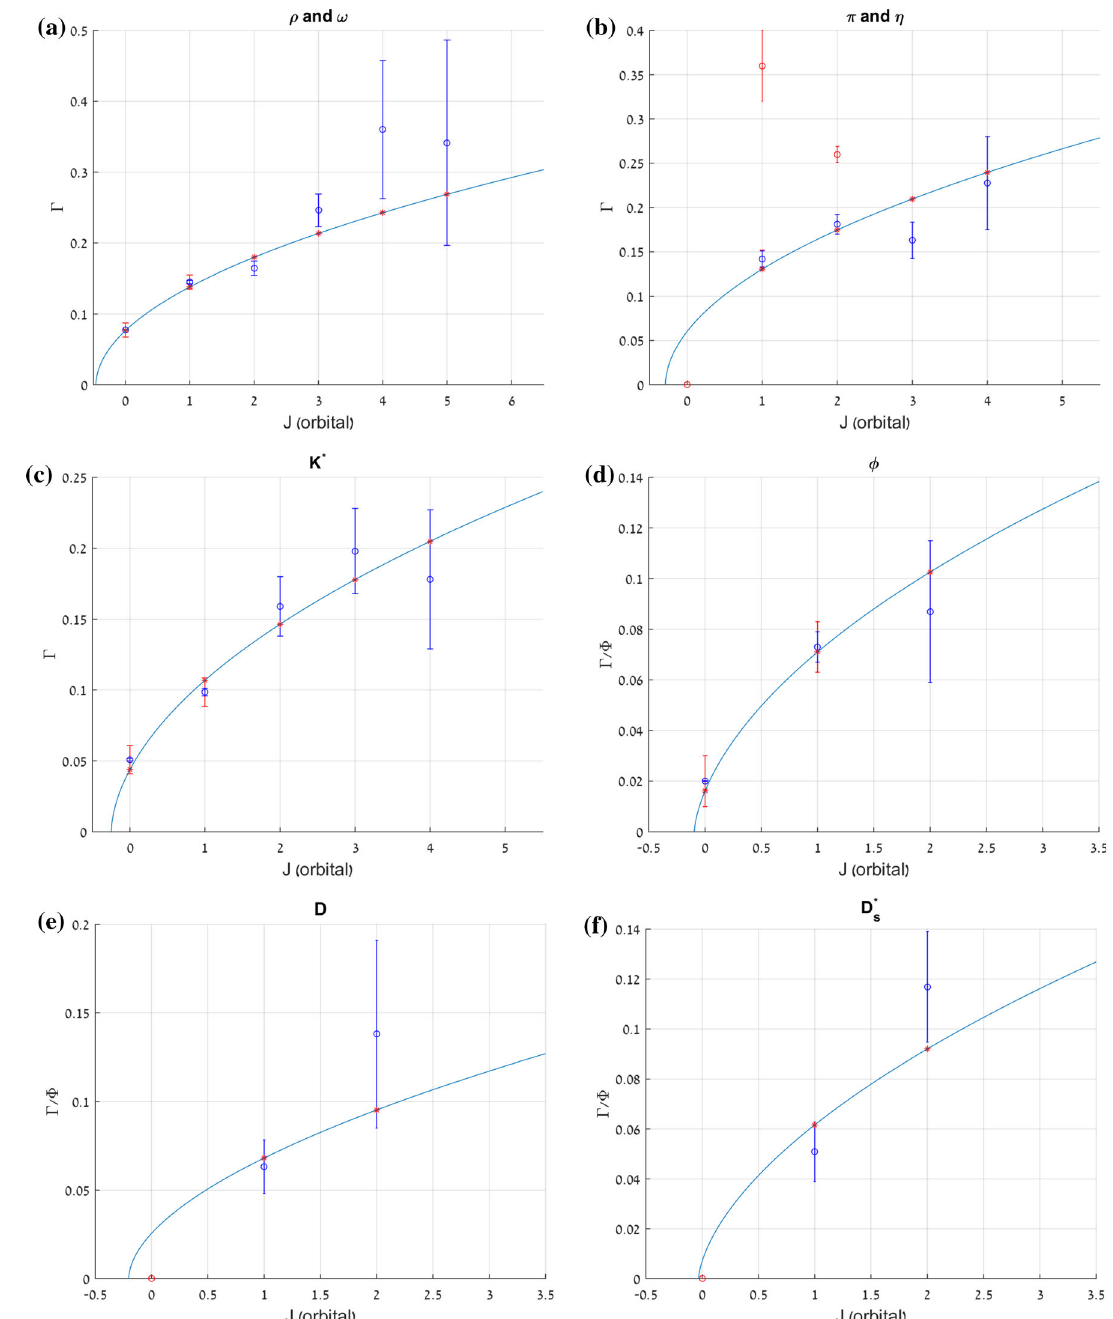
Fig. 5 The meson decay width fits of [6]. We plot the decay width (cid:17) (in some cases normalized by phase space factor as (cid:17)/(cid:18) ) as a func- tion of the orbital angular momentum. In blue are the data points, and